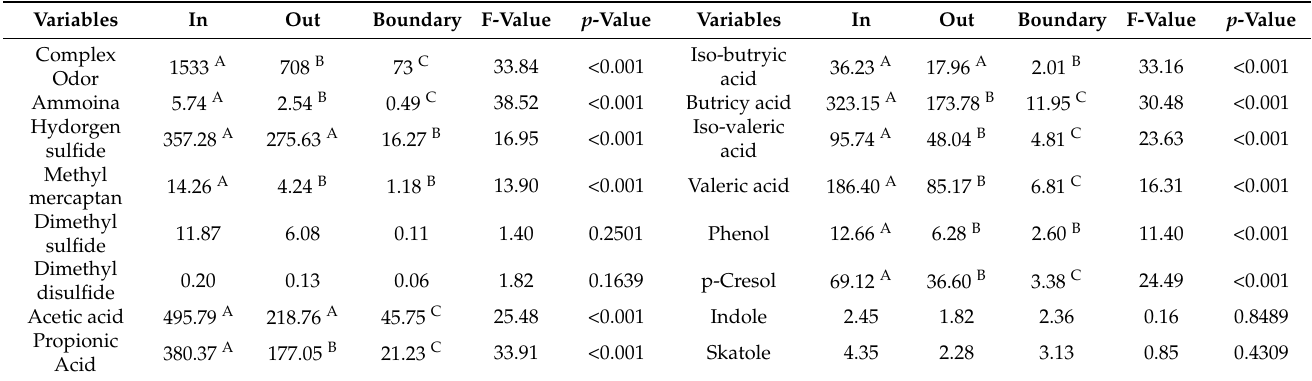
the mean of each category in the case of variables with significant differences in